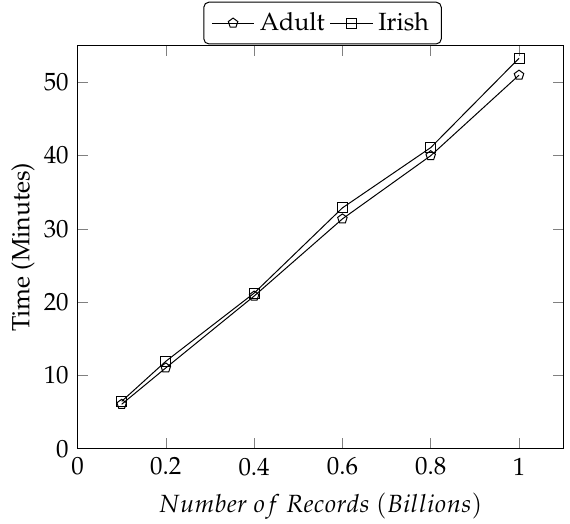
Figure 6. Scalability comparison for Adult and Irish dataset.